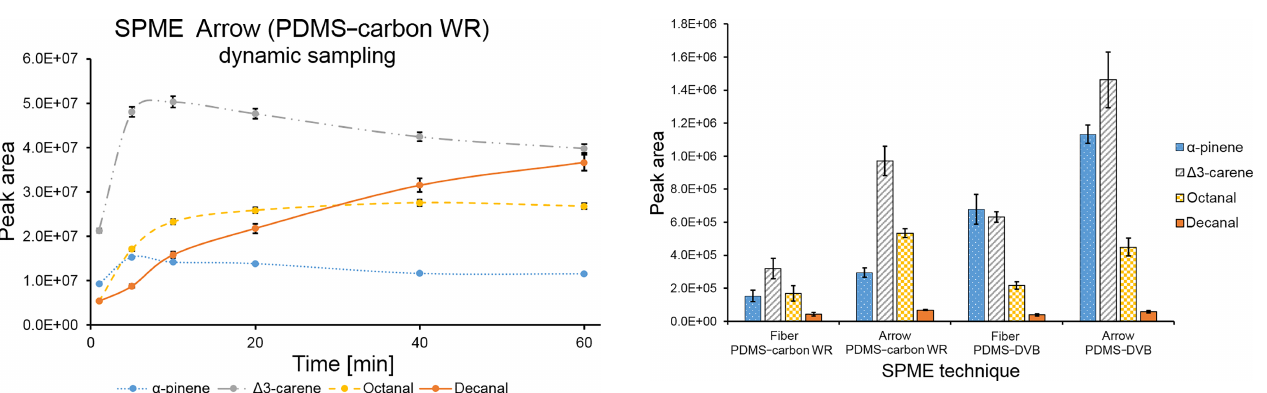
Figure 2. Extraction time profiles obtained for the studied ana- lytes using dynamic sampling by SPME Arrow coated with PDMS– carbon WR.